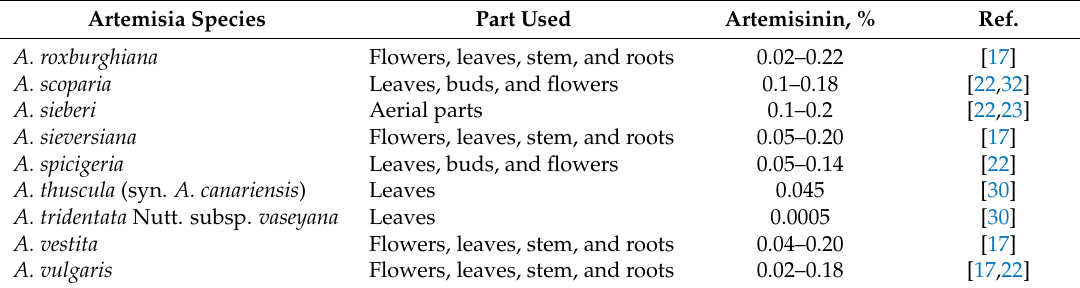
Figure S2: HPLC chromatogram of hexane extract of Artemisia vachanica (A) and Artemisia vulgaris (B), Figure S3: HPLC chromatogram of hexane extract of Artemisia makrocephala (A) and Artemisia leucotricha (B), Figure